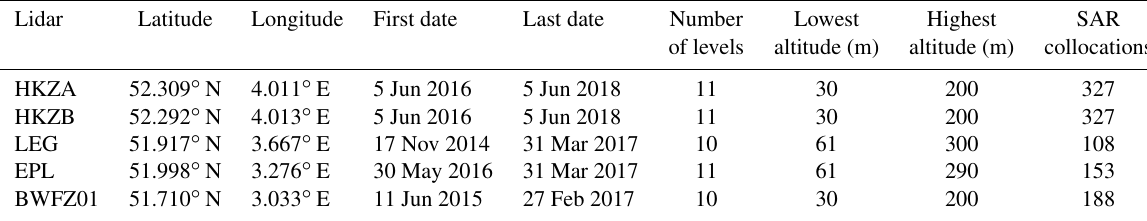
Table 1. Main characteristics of the five profiling lidars. Lidar Latitude Longitude First date Last date Number Lowest Highest SAR